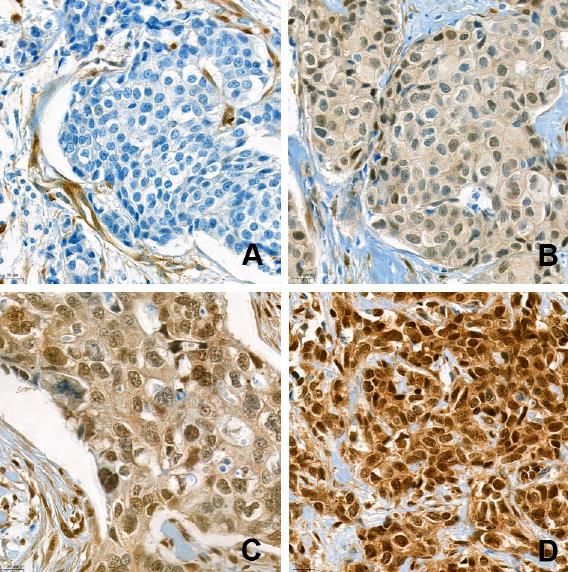
Fig 1. Immunohistochemical analysis of nuclear YAP1 expression. IHC analysis was evaluated in high-power fields (400x magnification) by an experienced pathologist. The sample were classified as negative (a), 1+ (b), 2+ (c), and 3+ (d), based on the intensity of YAP1 nuclear staining.